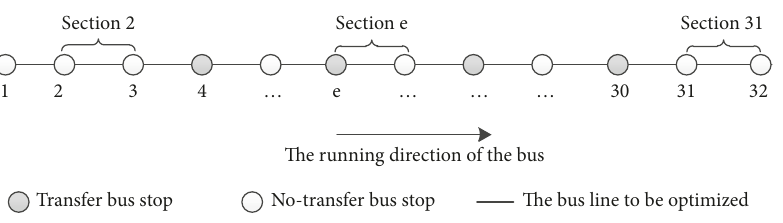
Figure 7: The long through-type bus line.